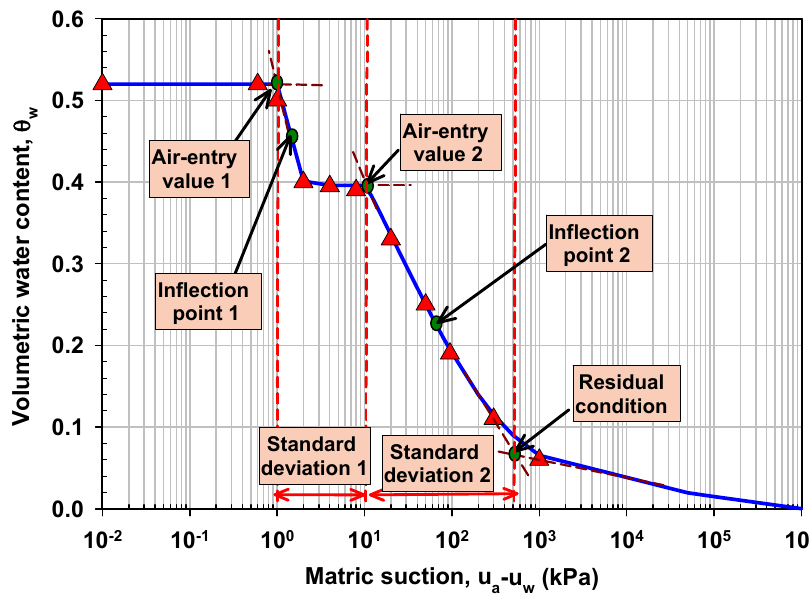
Figure 1. Variables of bimodal water retention curve.